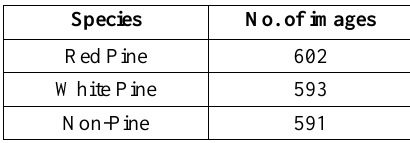
Figure 7. Tree crown delineation